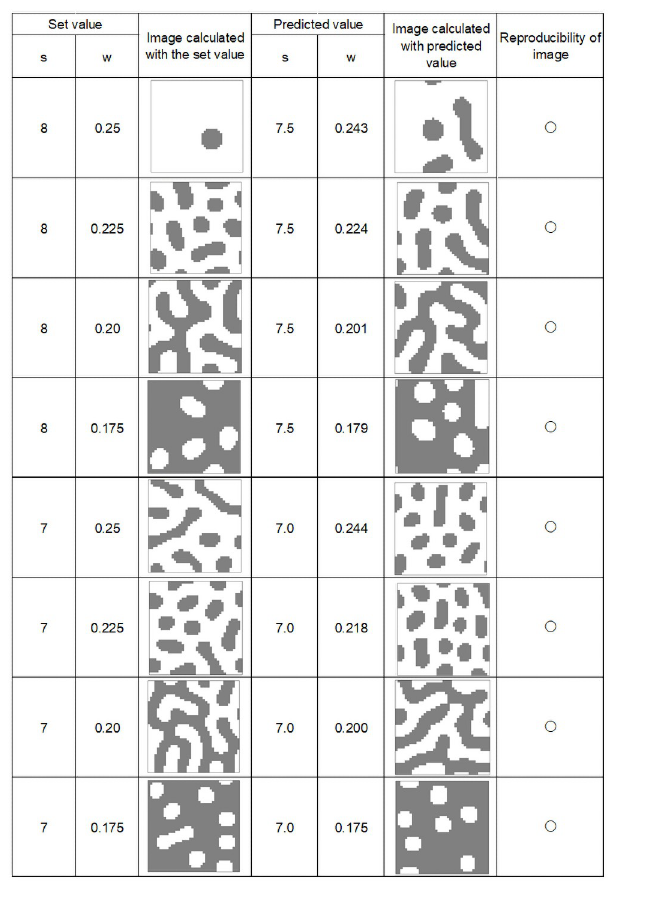
Fig 8. Calculation results